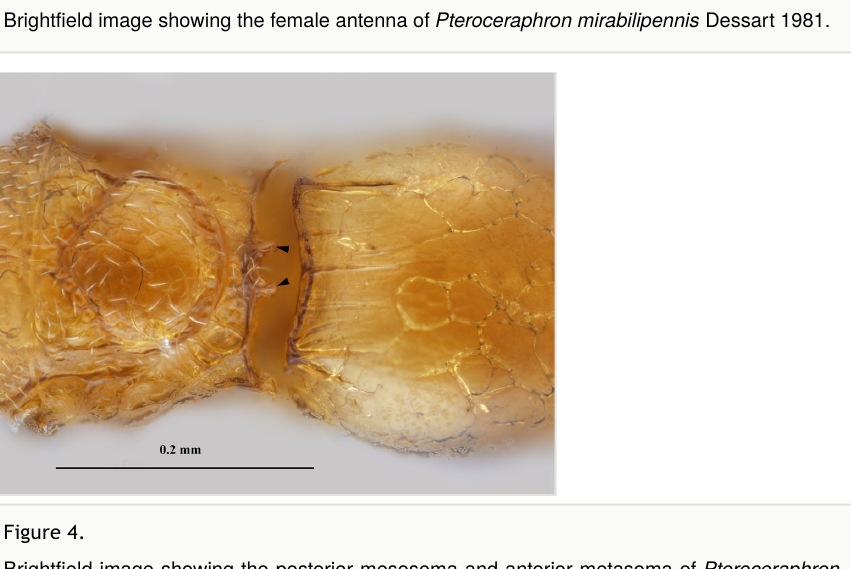
Bright fi eld image showing the posterior mesosoma and anterior metasoma of Pteroceraphron mirabilipennis Dessart 1981. Arrows point to bifurcated anteromedian process of the propodeum-metanotum